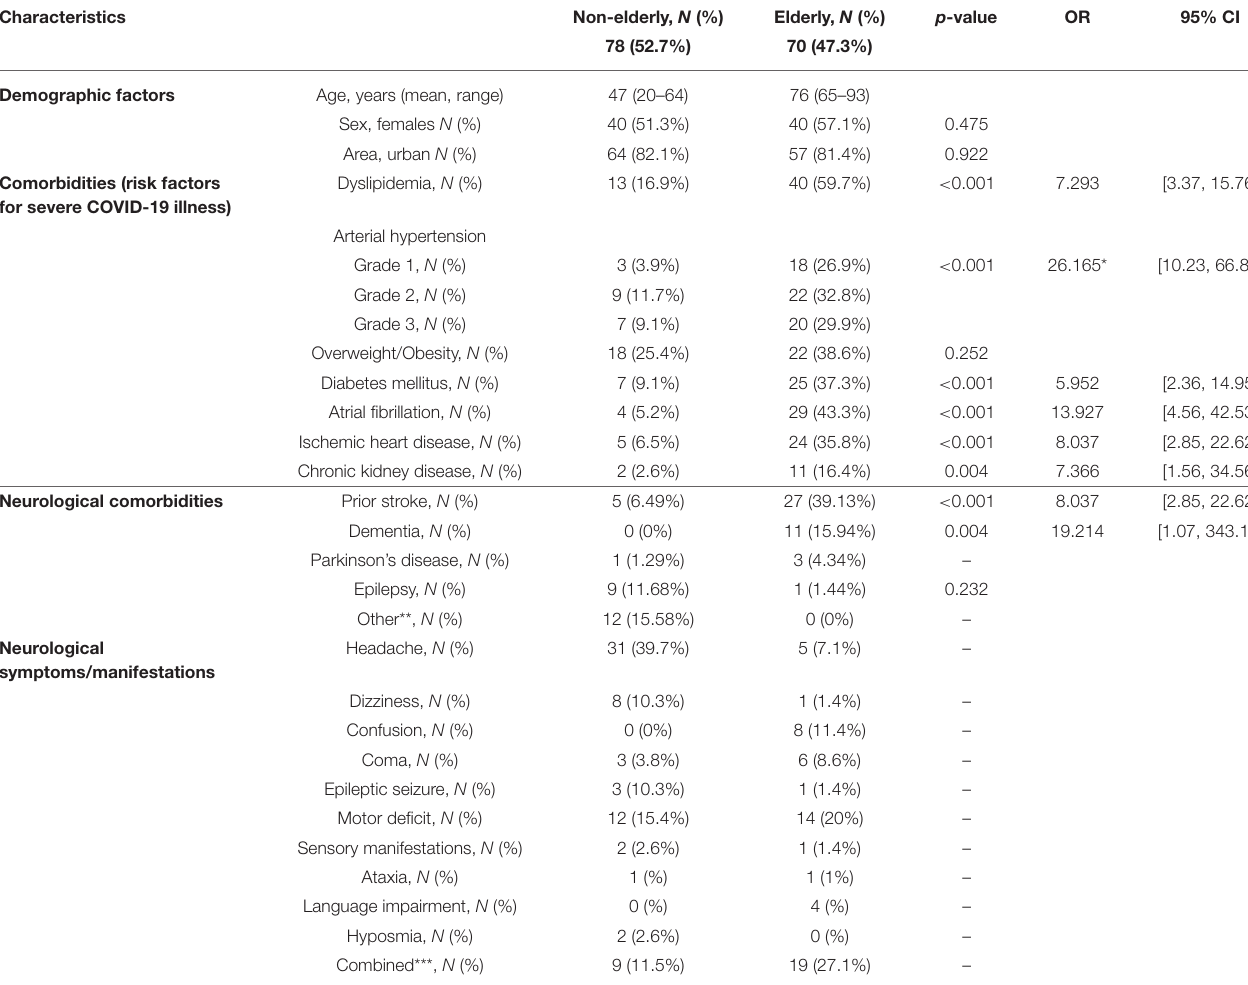
TABLE 1 | Demographic and clinical characteristics of patients.